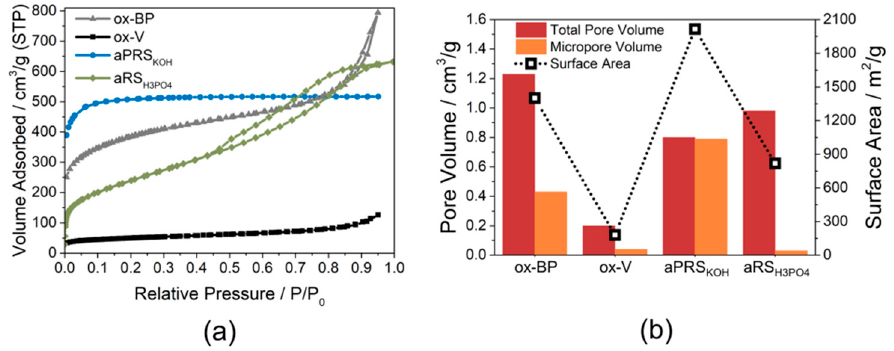
Figure 2. ( a ) Nitrogen sorption isotherms of four different carbon supports; ( b ) surface areas and total- and micropore volumes.